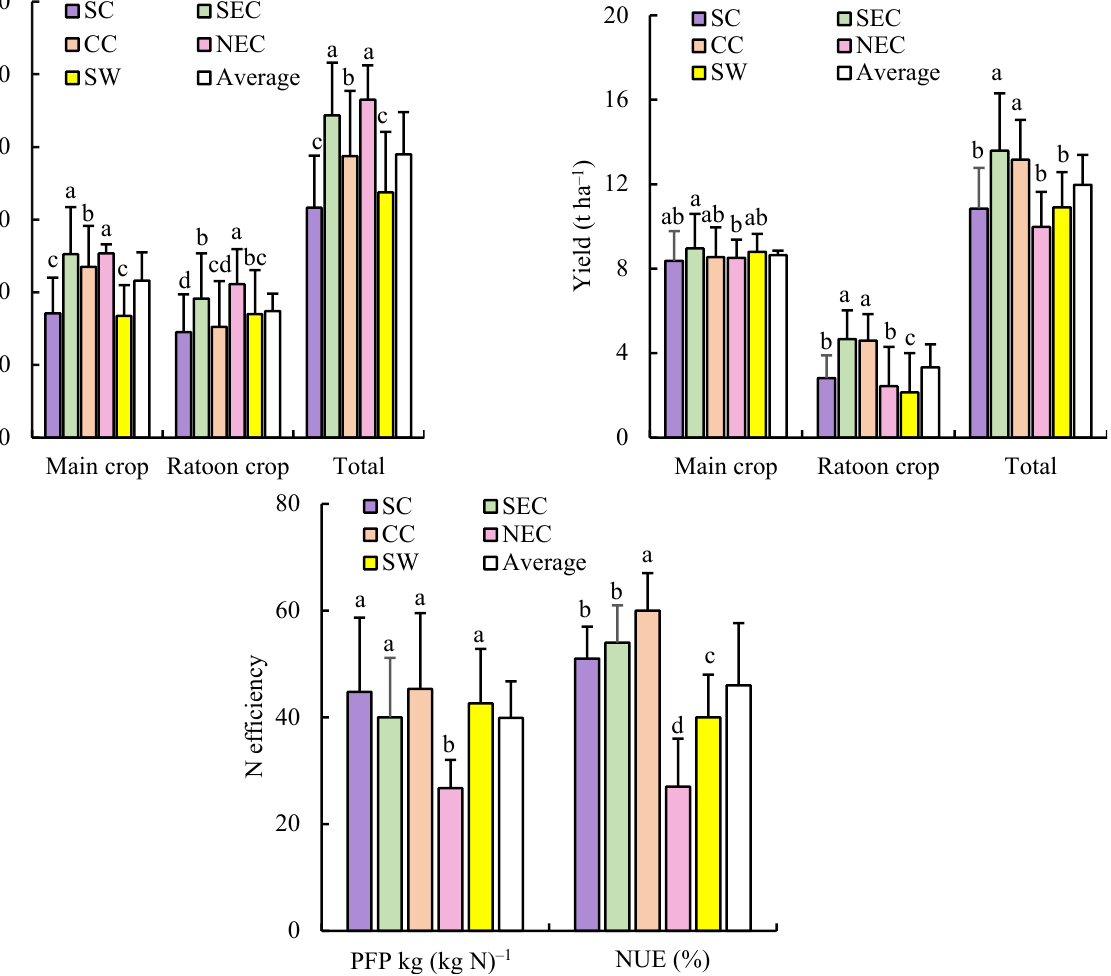
Figure 2. Estimation of yield, N application, and N efficiency of RR in different regions Values are means ± SD of three replicates. Different lowercase letters on bars indicate significant differences at p < 0.05.